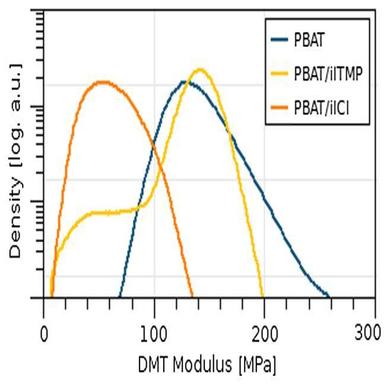
Representative logarithmic distributions of DMT modulus over AFM images for each blend. The vertical axis represents the density of probability